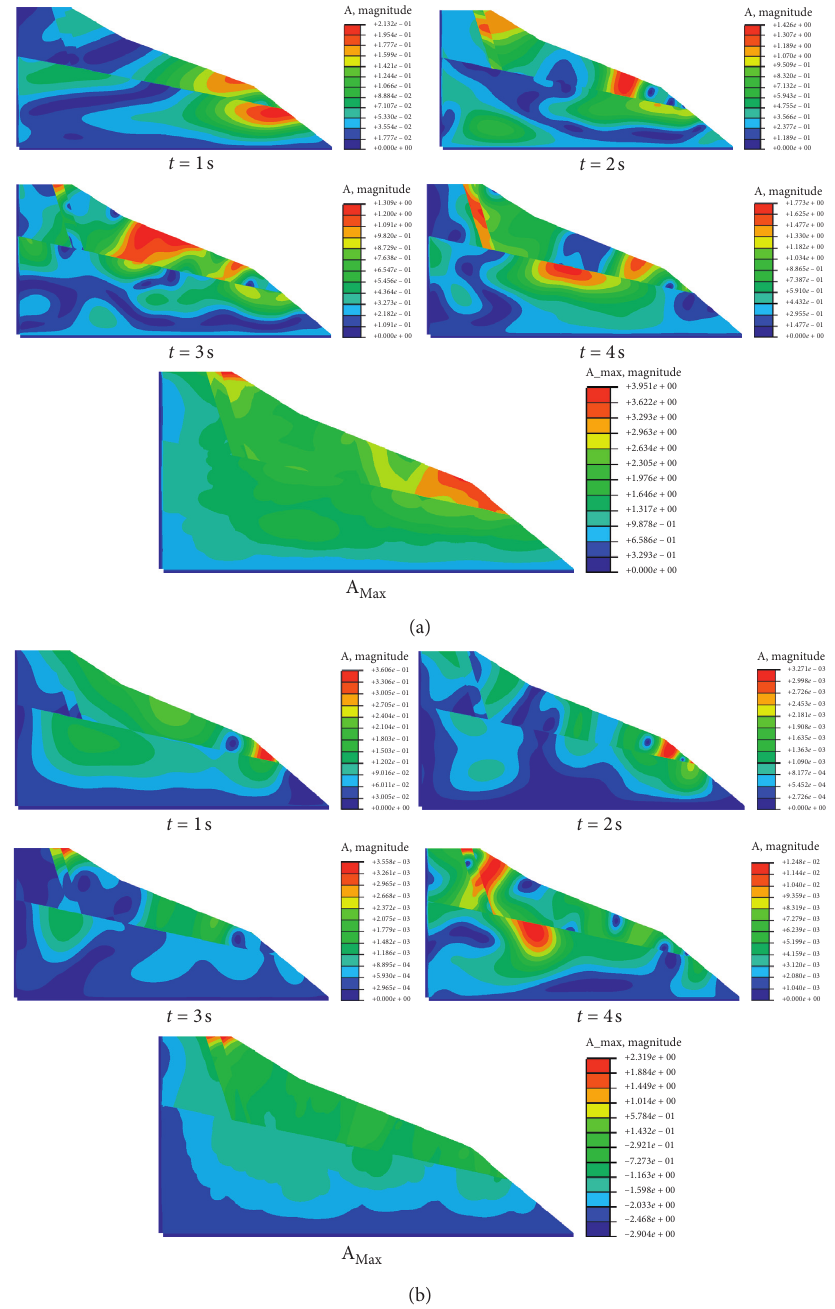
Figure 6: Acceleration response of Huaping slope: (a) input in x direction; (b) input in z